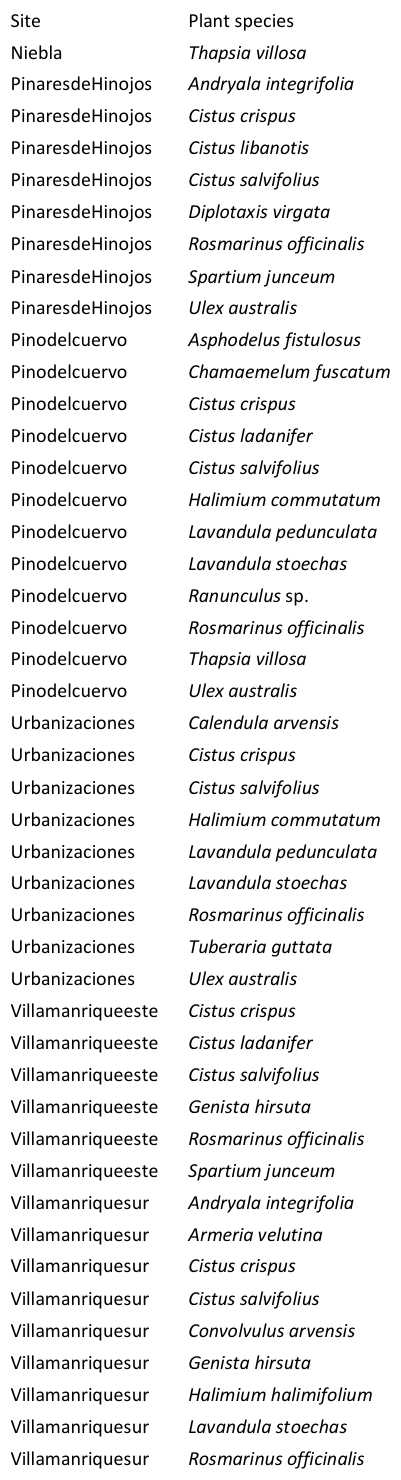
Table S1B. List of all pollinator species present at each of the sites and included in network analyses.